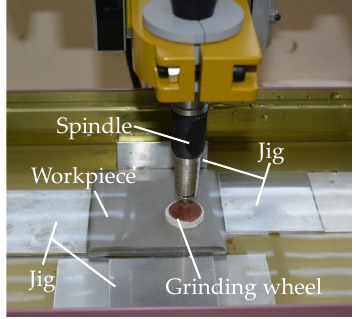
Figure 3. Wet tabletop grinding equipment.